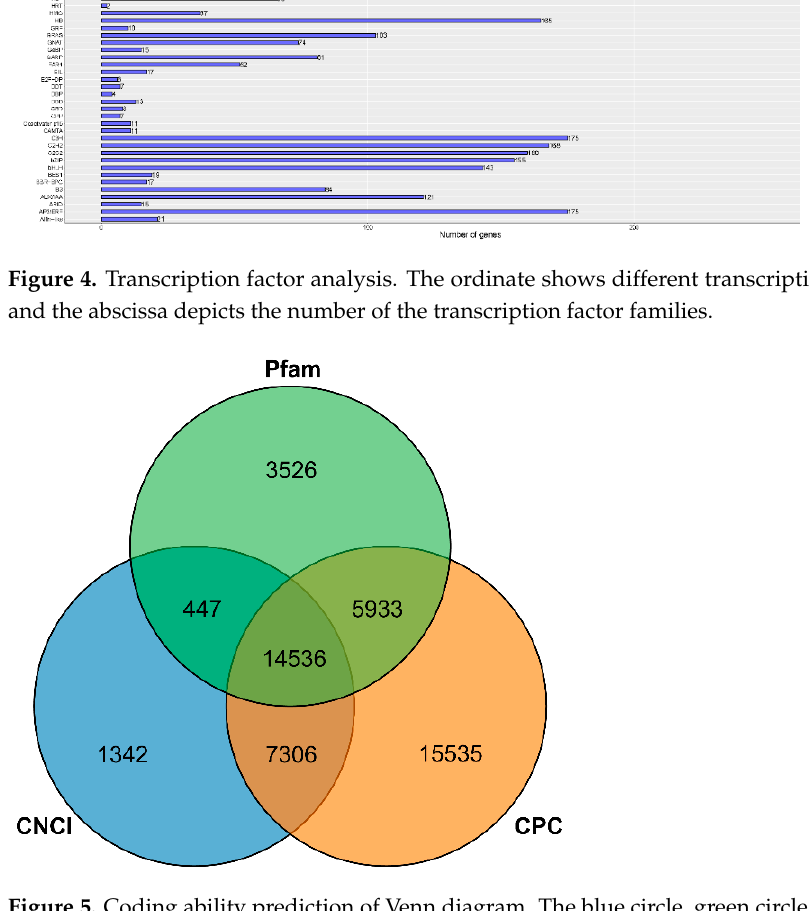
Table 3. Results of SSR analysis.